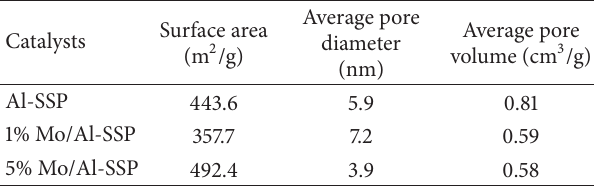
Table 1: Textural properties of the catalysts.